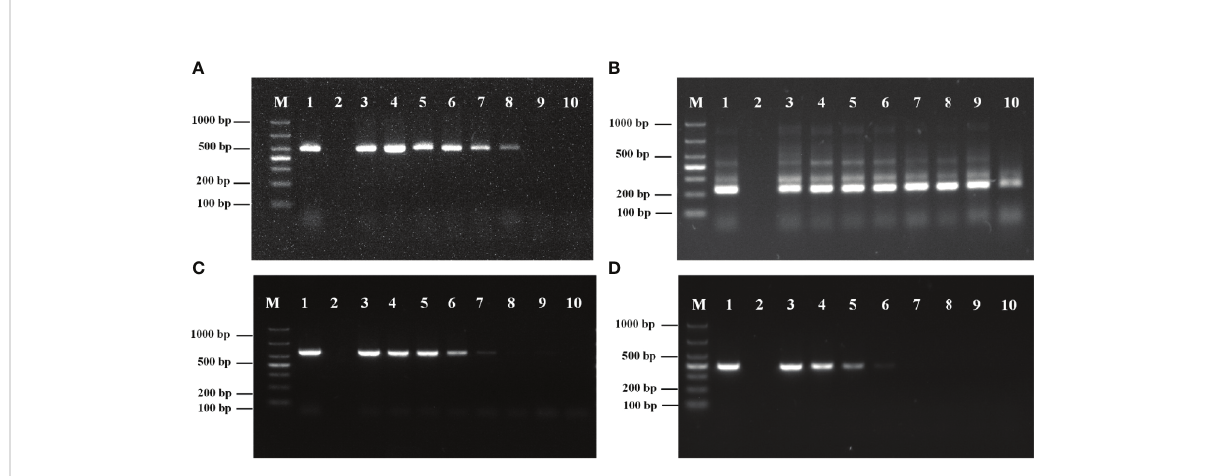
FIGURE 3 (A) Sensitivity analysis of primers P1/P2. (B) Sensitivity analysis of primers PN1/PN2. M: Marker; 1: DNA of Metschnikowia bicuspidata ; 2: